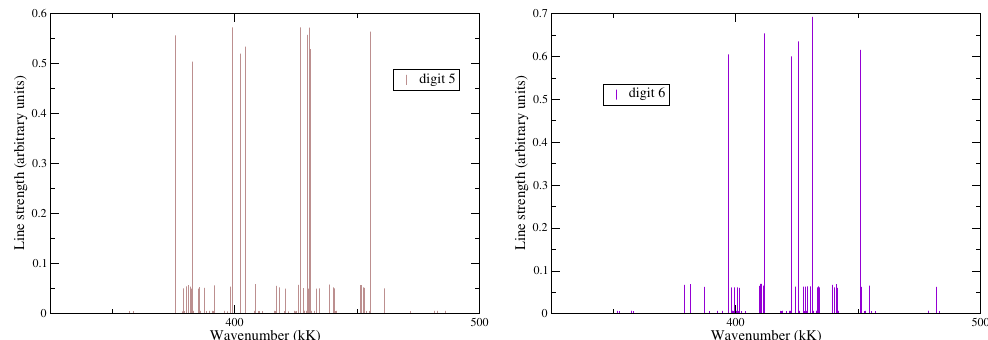
Figure 14. Number of lines with a first significant digit of 5 ( left ) and 6 ( right ) in their strength, as a function of their energy, for transition array 3 d 4